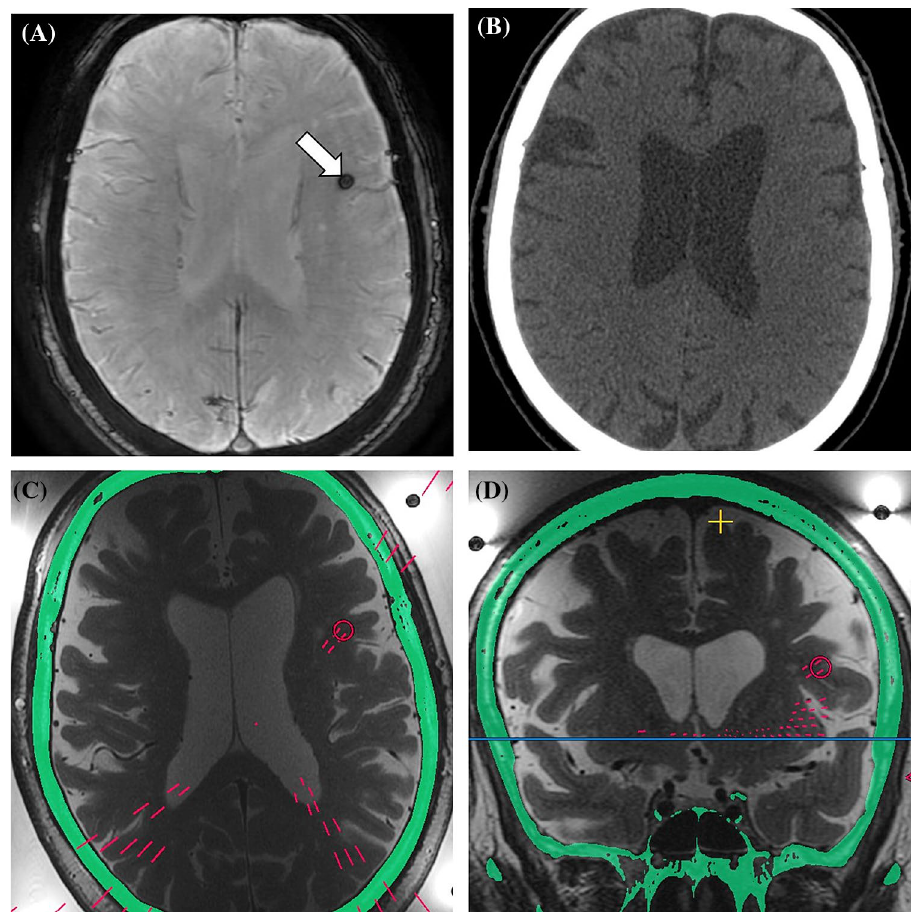
Figure 3. 70-year-old man with essential tremor. Preoperative SWAN sequence detects a hypointense lesion in the left frontal lobe ( A , arrow), not corresponding to calcification on CT image ( B ). Axial and coronal intraoperative T2-weighted FRFSE show the no-pass region that was placed during treatment planning [red circles in ( C ) and ( D )], blocking 4 additional elements (4.6% of the total elements turned